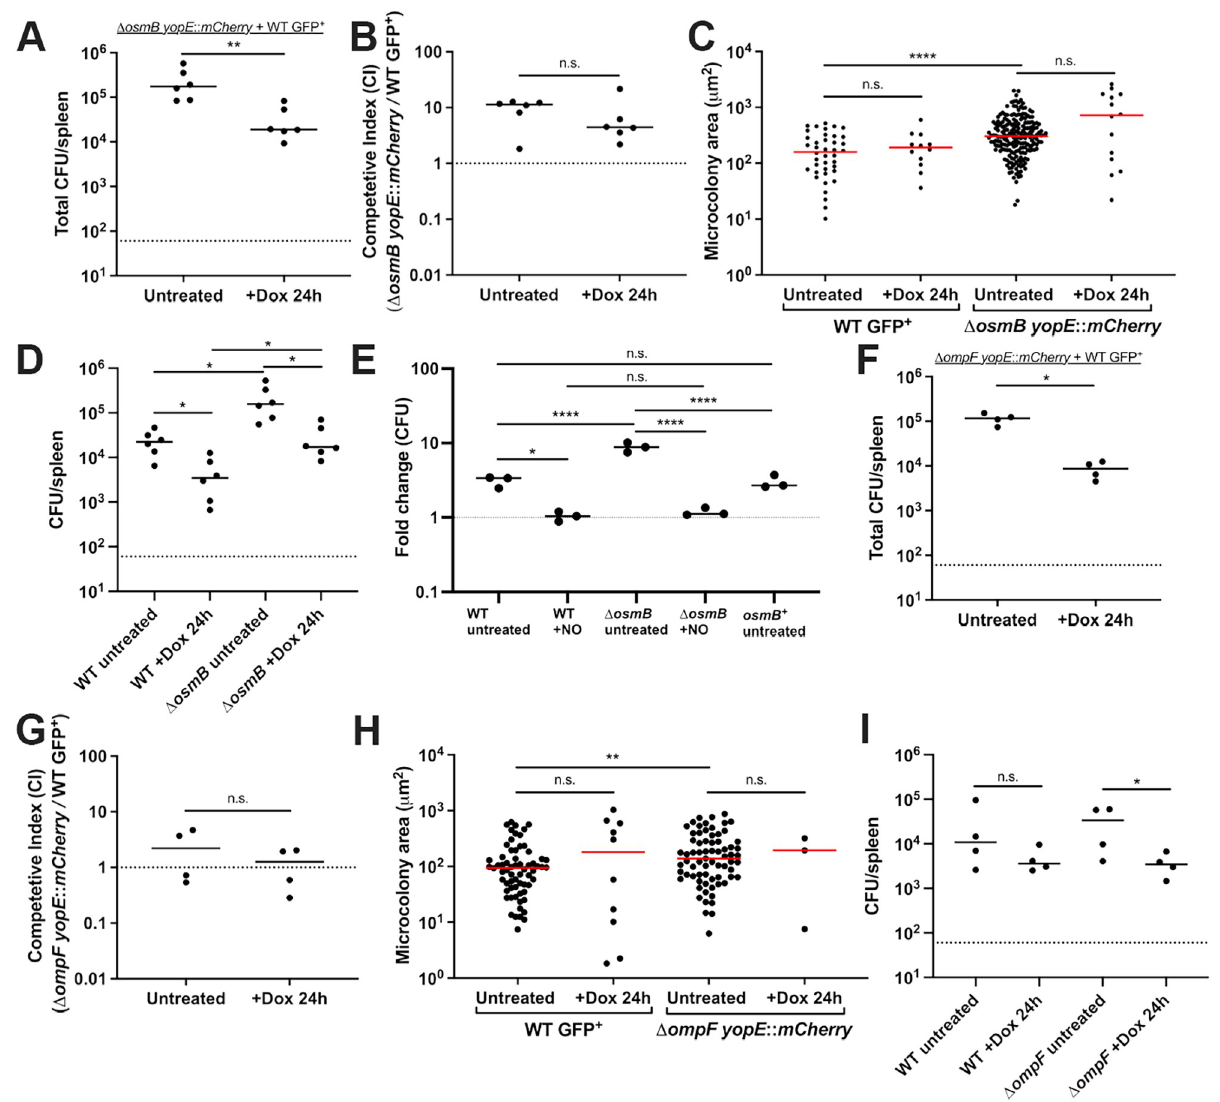
Fig 4. Δ osmB has increased in vivo fitness relative to the WT strain, Δ ompF does not appear significantly more susceptible to doxycycline in vivo . C57BL/6 mice were infected with equal numbers of WT and mutant Y . pseudotuberculosis , infection proceeded for 48h (hours, h), and mice were injected intraperitoneally with a single dose of Dox or left untreated. Spleens were harvested 24h later to quantify CFUs and microcolony areas. (A) Co- infection with Δ osmB yopE :: mCherry + WT GFP + . Total CFU/spleen for treated mice (+Dox 24h) compared to untreated mice at the same timepoint. Dots: individual mice. (B) Competitive index: CFUs of the mutant/WT in the spleen divided by the ratio of mutant/WT in the inoculum. Values above 1: mutant is more fit. Dotted line: value of 1, equal fitness. Dots: individual mice. (C) Microcolony areas were quantified for individual strains within the harvested spleens (6 untreated mice and 6 treated mice). 20–62 microcolonies were quantified in one section for untreated mice, and 1–13 microcolonies were quantified in one section for treated mice. (D) CFU/spleen of each strain in the Δ osmB + WT competition experiments. (E) Fold change in bacterial growth after 4h culture in the presence (+NO) or absence (untreated) of the NO donor compound, DETA-NONOate (2.5mM). WT, Δ osmB , and osmB + ( osmB rescued strain) are compared. Fold change relative to time 0, dotted line represents time 0 values. ( F ) Co-infection with Δ ompF yopE :: mCherry + WT GFP + . Total CFU/spleen for treated mice (+Dox 24h) compared to untreated mice at the same timepoint. Dots: individual mice. (G) Competitive index: CFUs of the mutant/WT in the spleen divided by the ratio of mutant/WT in the inoculum. Values above 1: mutant is more fit. Dotted line: value of 1, equal fitness. Dots: individual mice. (H) Microcolony areas were quantified for individual strains within the harvested spleens (4 untreated mice and 4 treated mice). 14–72 microcolonies were quantified in one section for untreated mice, and 1–7 microcolonies were quantified in one section for treated mice. (I) CFU/spleen of each strain in the Δ ompF + WT competition experiments. All mouse experiments were carried out on two independent days. Statistics: (A, B, C, F, G, H) Mann-Whitney; (E) One-way ANOVA with Tukey’s post-test; (D, I) Kruskal-Wallis one-way ANOVA with Dunn’s post-test. ���� p < .0001, �� p < .01, � p < .05, n.s.: not